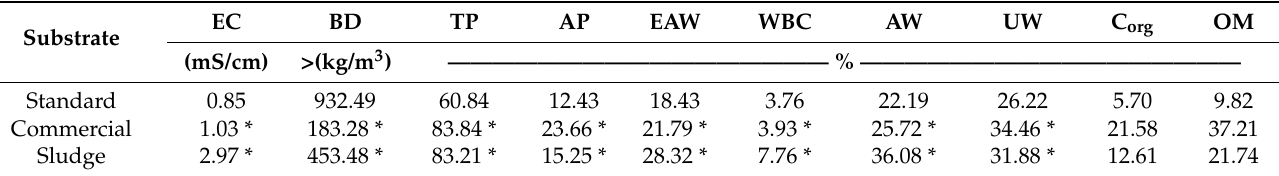
Table 4. Physical properties (methodology in [31]), organic carbon, and organic matter of substrates used to produce Samanea saman seedlings with different substrates and inoculation